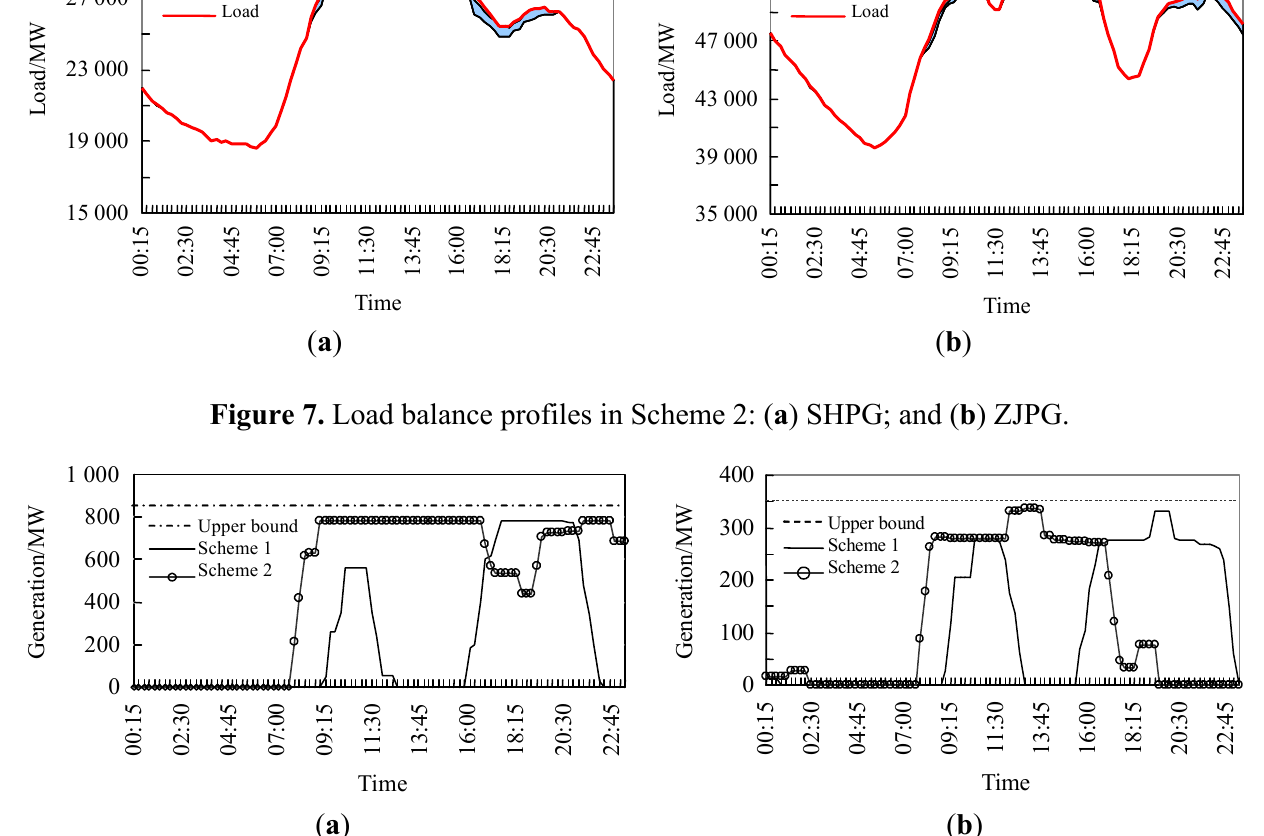
Figure 8. Generation output of plants in certain periods: ( a ) Xinanjiang Plant; and ( b ) Fuchunjiang